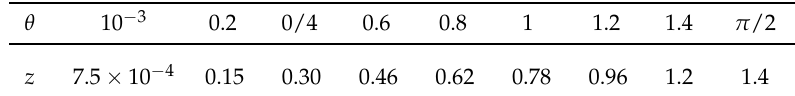
Table 2. Self-similar solution for y = 1, from Reference